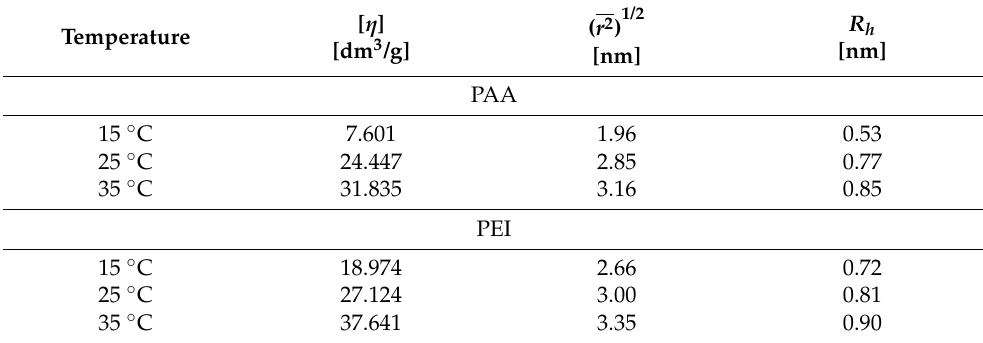
Table 2. Characteristics of linear dimensions of poly(acrylic acid) and polyethyleneimine macro- molecules in the aqueous solutions at pH 3 under different temperature